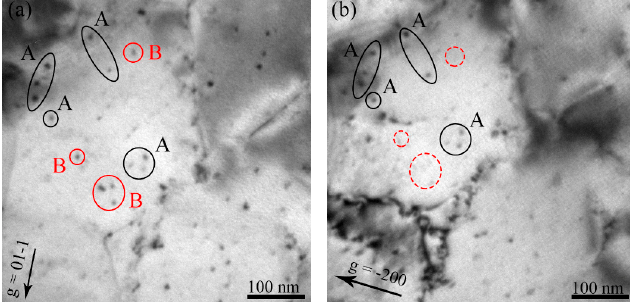
Figure 4. TEM bright field micrographs of dislocation loops in the specimen irradiated to 5 × 10 20 H + • m − 2 at 523 K. ( a ) g = 01-1, ( b ) g = − 200 near the pole [011]. The Burgers vector of family A loops is b = (cid:2869) (cid:2870) a 0 <111>, which of family B loops is b = a 0 <100>.